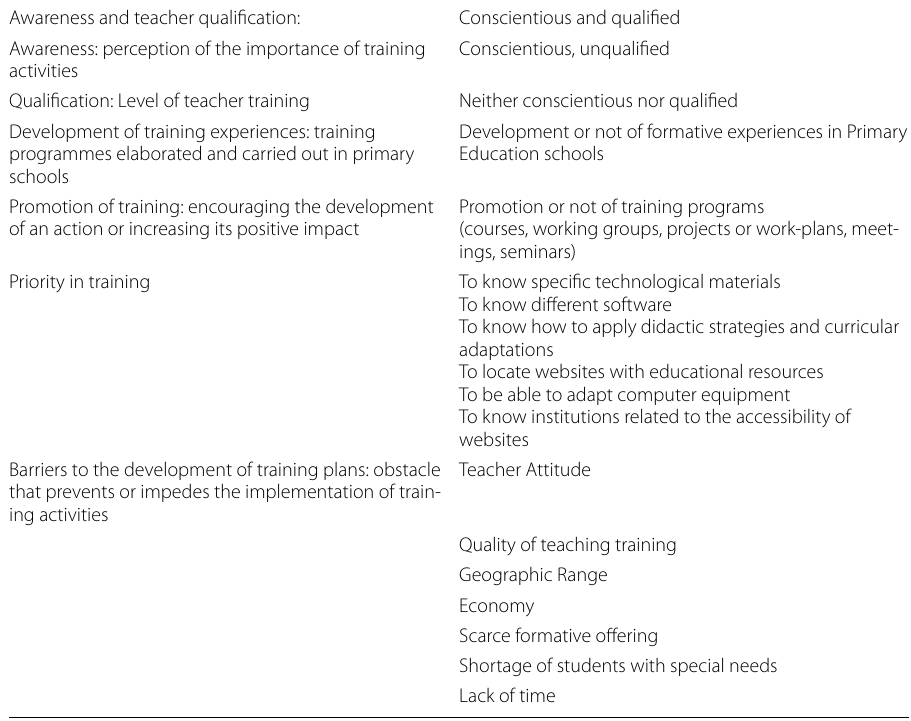
Table 2 Category system Awareness and teacher qualification: Conscientious and qualified Awareness: perception of the importance of training